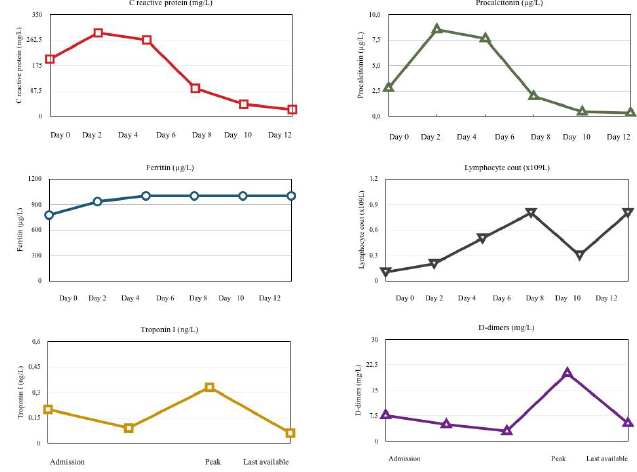
Figure 2. Inflammatory markers in peripheral blood of patient during the treatment.